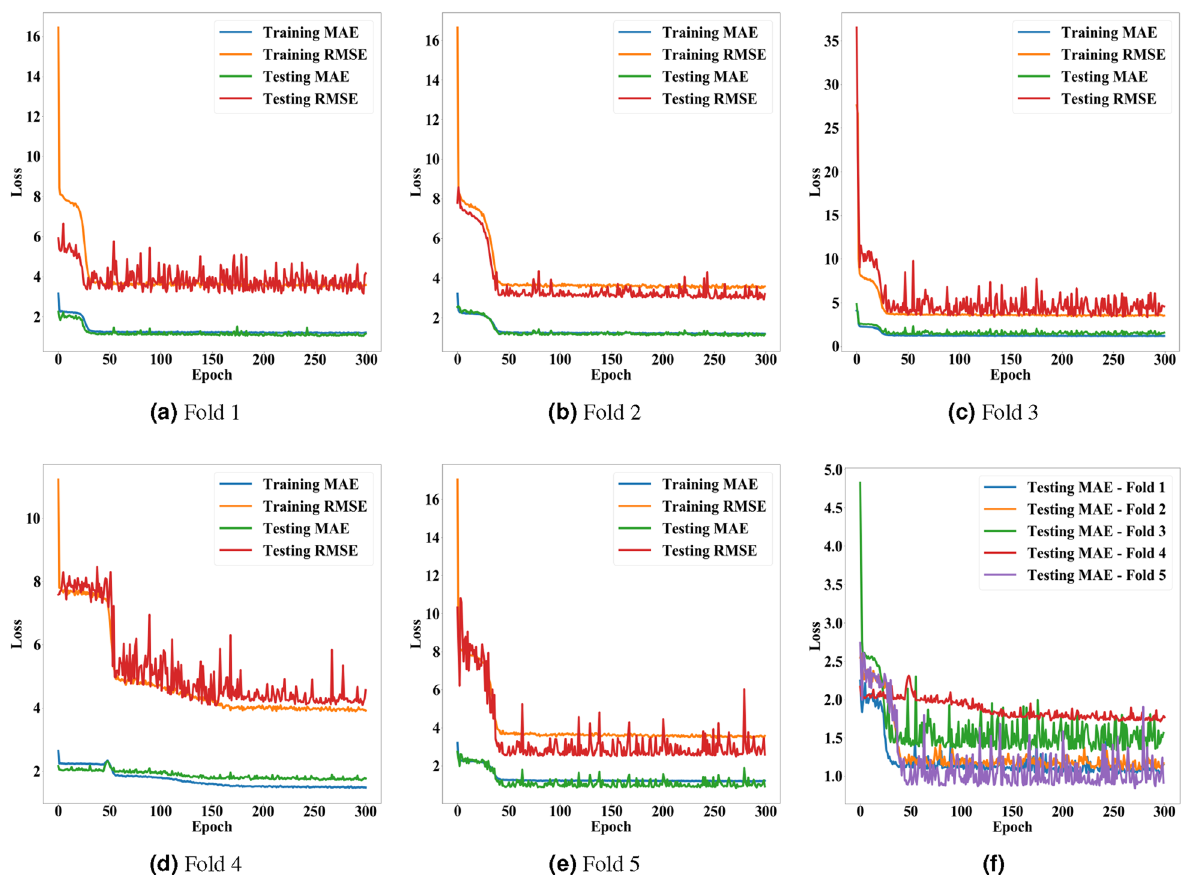
Figure 10. Accuracy of the proposed method for estimating non-linear elastic moduli according to epochs. ( a – e ) present the MAE and RMSE of the proposed model on the training and testing data from the 1st to 5th folds. ( f ) shows a comparison of the five folds with each other in terms of MAE.